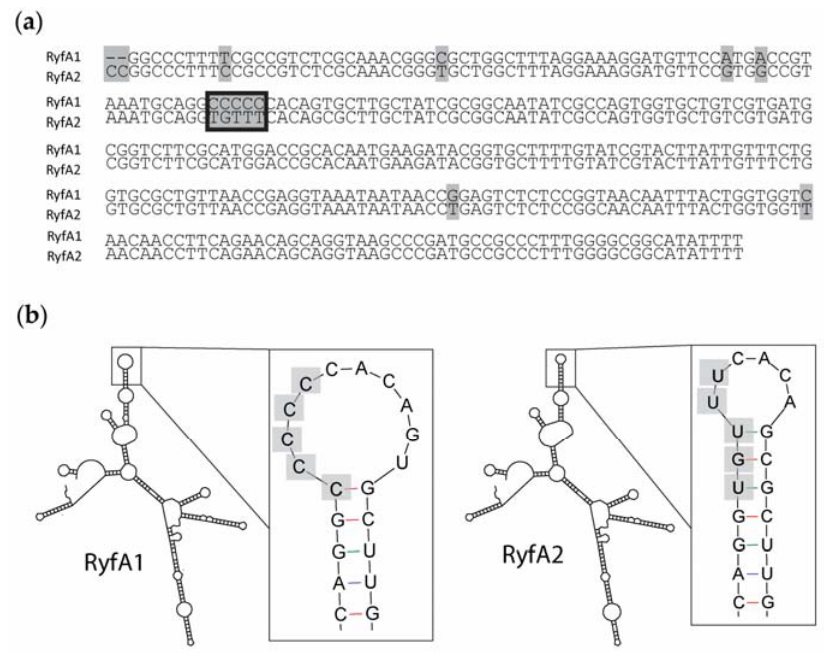
Figure 2. RyfA1 and RyfA2 structure and sequence. ( a ) The predicted genes ryfA1 and ryfA2 were aligned using Clone Manager version 9. The genes encoding the sibling RyfA molecules are 95% identical in S. dysenteriae . Nucleotide differences between ryfA1 and ryfA2 are highlighted with light gray rectangles and the identified five nucleotide “variable region” of each is boxed in black. ( b ) The mfold Web Server [28] was used to predict the structures of RyfA1 and RyfA2. Although the predicted structure between each sibling RyfA is nearly identical, the stem loops outlined in the black boxes vary between the two molecules. The observed structural differences between RyfA1 and RyfA2 result from the varied nucleic acid sequences within the five nucleotide variable region (as indicated by the gray boxes) identified upon a comparison of each ryfA gene.